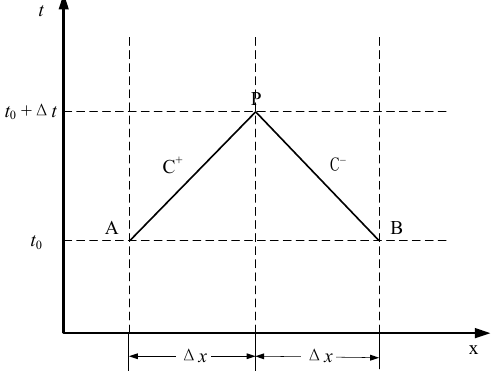
Figure 2. Positive and negative water hammer characteristic lines.